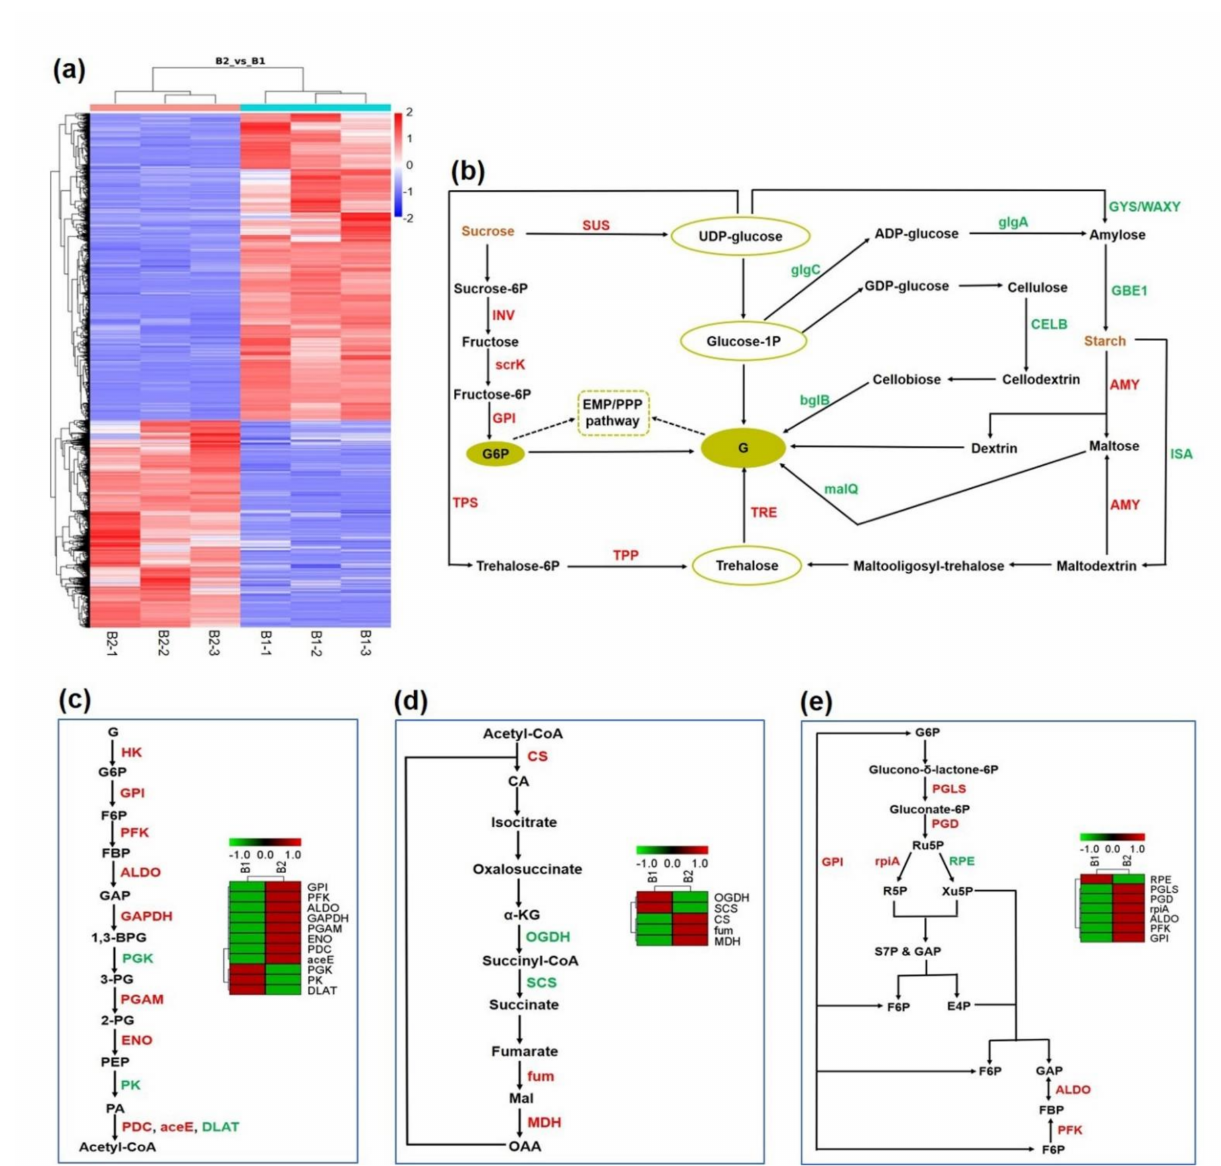
Figure 2. Differential expression analysis in total transcriptome. ( a ) Cluster analysis of differen- tially expressed genes. ( b – e ) Expression changes of key enzyme genes involved in different energy metabolism pathways at two development stages. Key players in starch and sucrose metabolism ( b ), EMP ( c ), TCA cycle ( d ) and PPP ( e ) pathway: the red letters represent upregulated genes and the green letters indicate downregulated genes. Abbreviations: B1, winter shoots; B2, spring shoots; G, glucose; G6P, glucose − 6 − phosphate; SUS, sucrose synthase; INV, invertase; GPI, glucose − 6 − phosphate isomerase; scrK, fructokinase; TPP, trehalose 6 − phosphate phosphatase; TRE, alpha, alpha-trehalase; TPS, trehalose 6 − phosphate synthase; GYS, glycogen synthase; WAXY, granule-bound starch synthase; GBE1, 1,4 − alpha-glucan branching enzyme; AMY, amylase; ISA, isoamylase; malQ, 4 − alpha-glucanotransferase; glgA, starch synthase; glgC, glucose − 1 − phosphate adenylyltrans- ferase; CELB, cellulase; bglB, beta-glucosidase; HK, hexokinase; F6P, fructose − 6 − phosphate; GPI, glucose-6 − phosphate isomerase; PFK, phosphofructkinase; FBP, fructose − 1,6 − bisphosphatase; ALDO, fructose-bisphosphate aldolase; GAP, fructose-bisphosphate aldolase; GAPDH, glyceralde- hyde phosphate dehydrogenase; 1, 3 − BPG,1, 3 − bisphosphoglycerate; PGK,phosphoglycerate